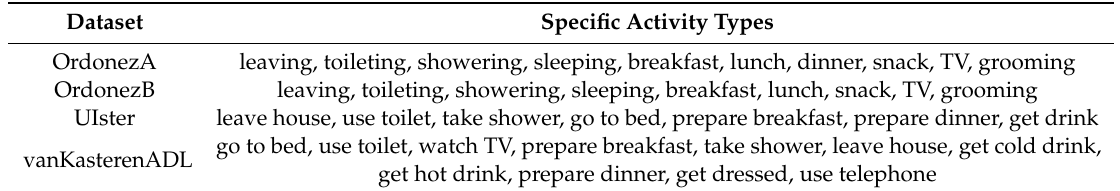
Table 2. Specific activity types in four